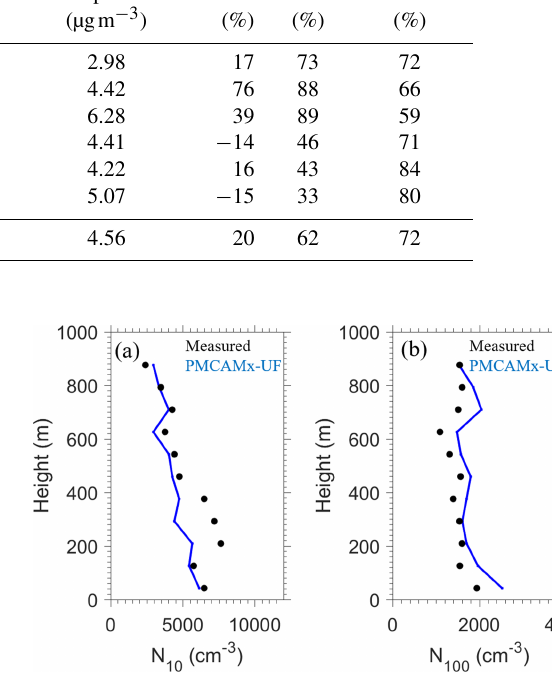
Figure 2. Comparison of predicted PMCAMx-UF (blue line) vs. observed (black dots) vertical profiles of averaged particle number concentrations for (a) N 10 and (b) N 100 of 25 flights over the Po Valley during the PEGASOS